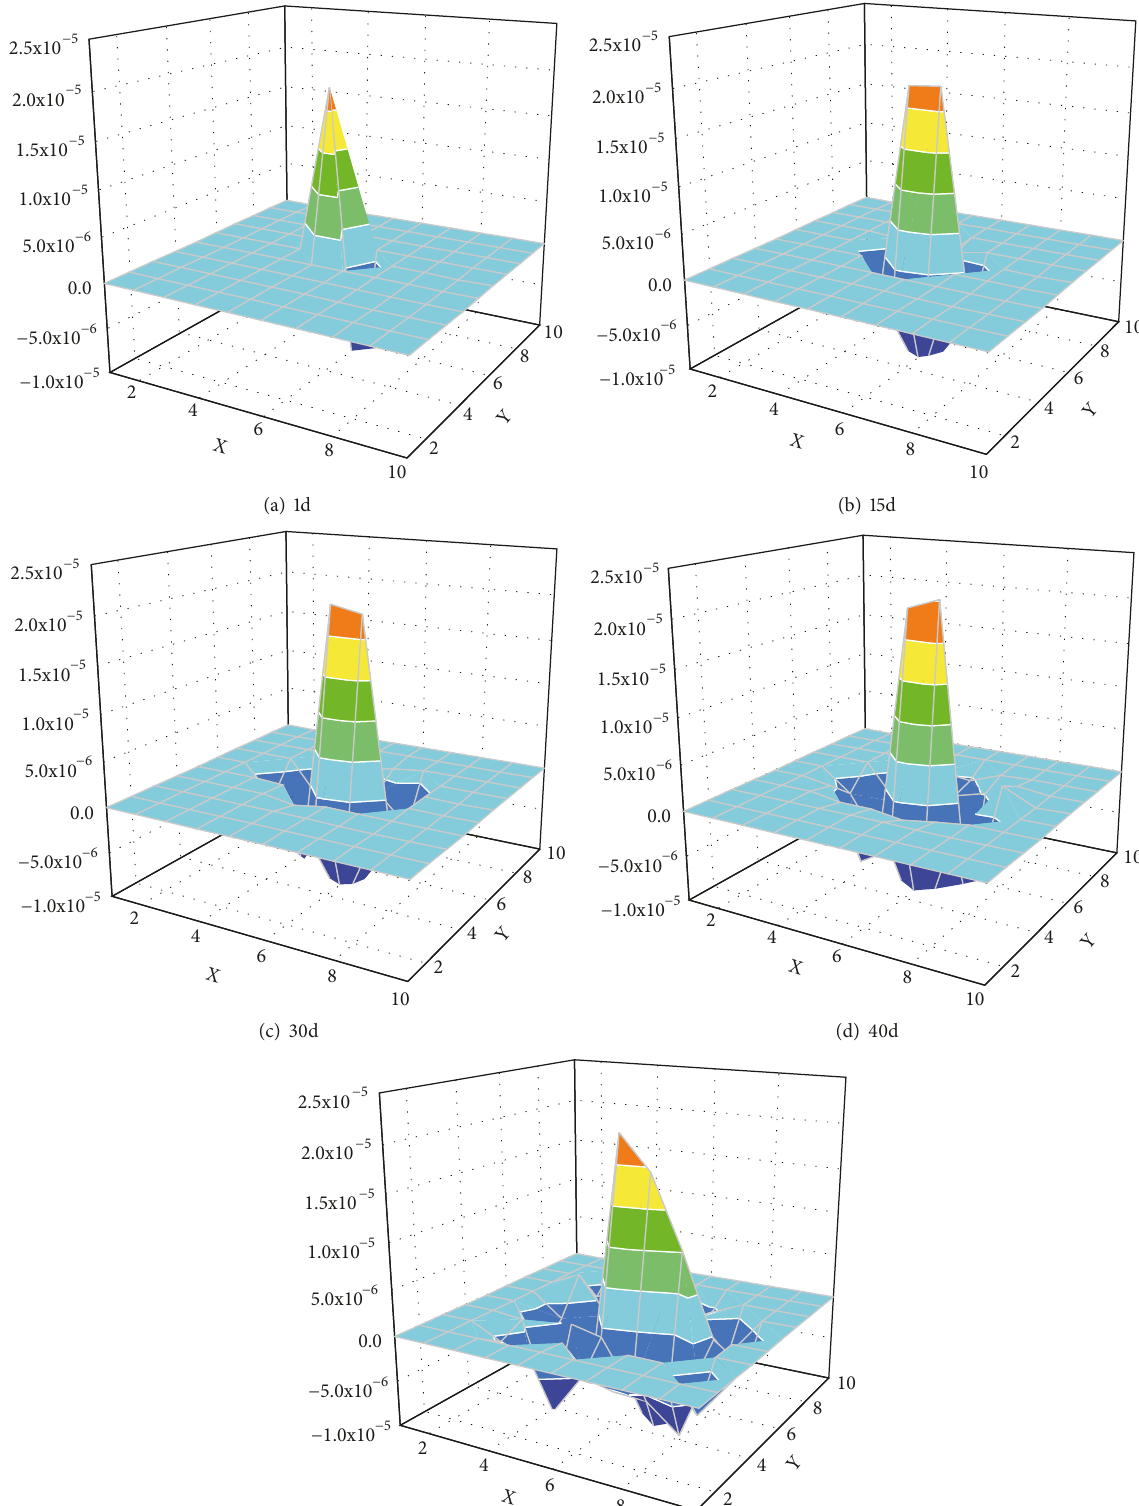
Figure 5: Current density distribution diagram of smear damage system in different days in 6% NaCl